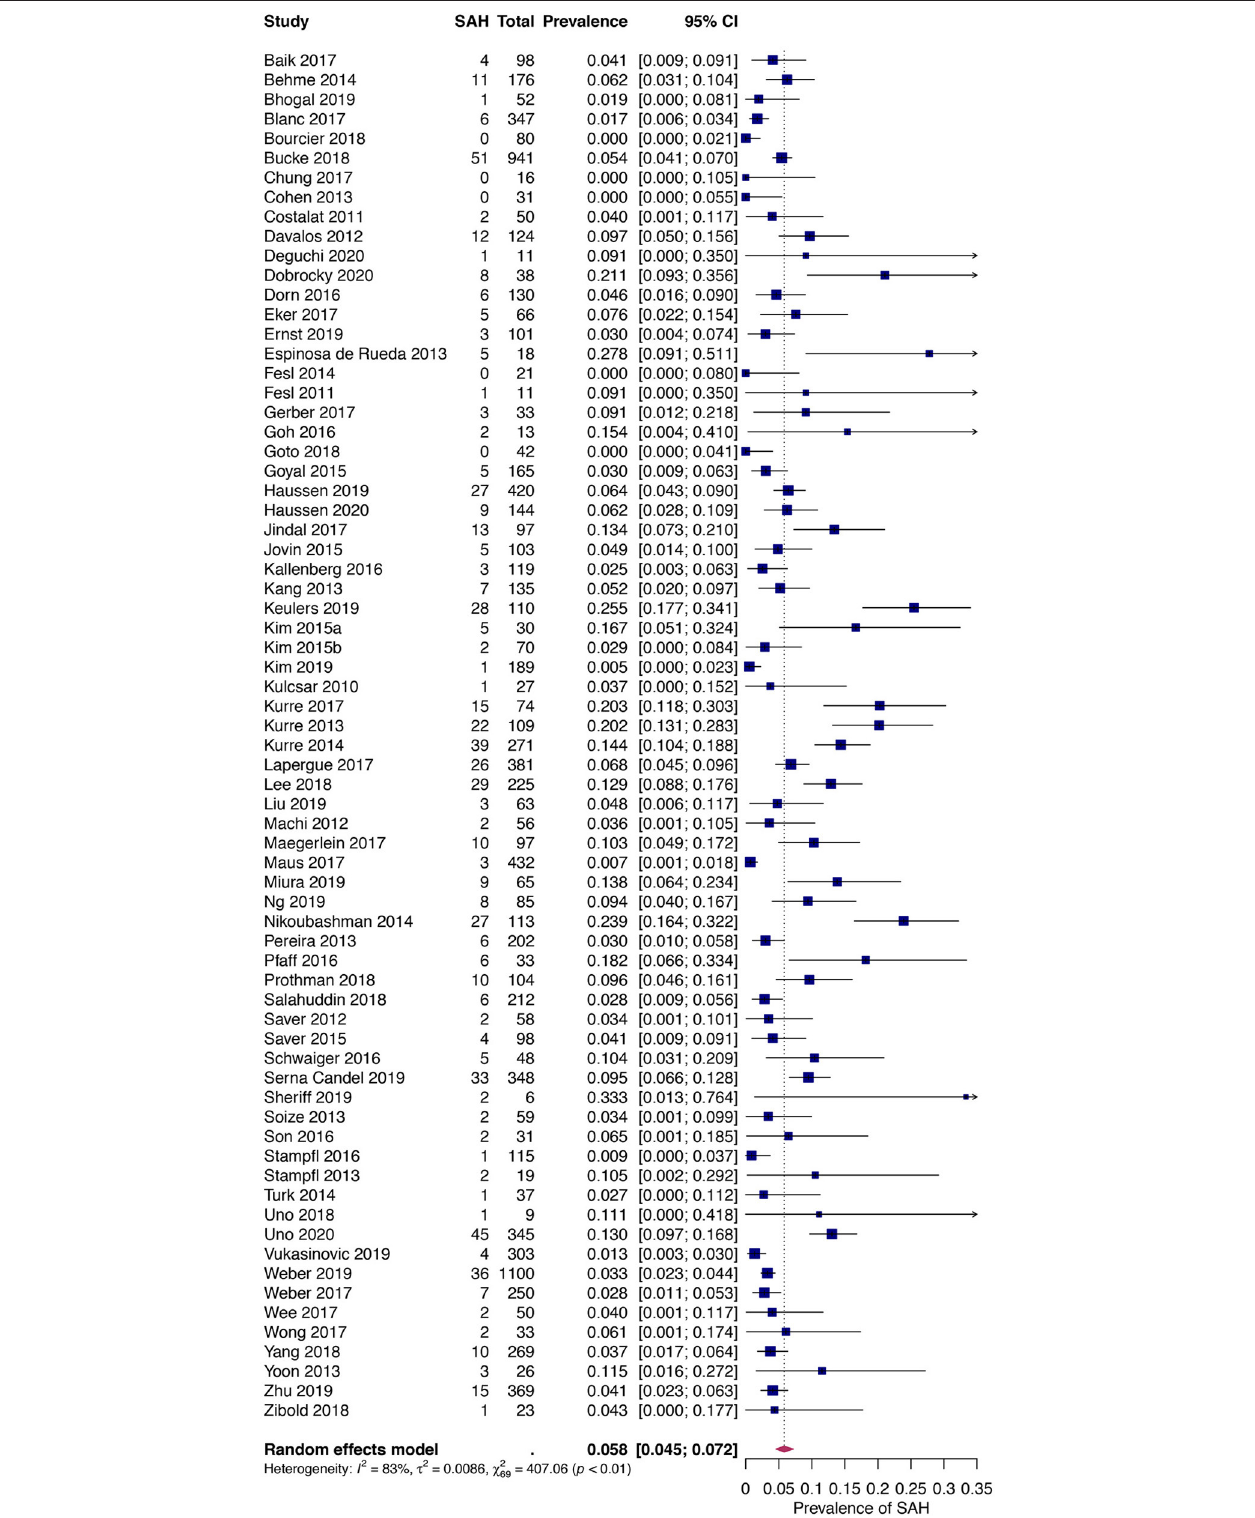
Frontiers in Neurology |